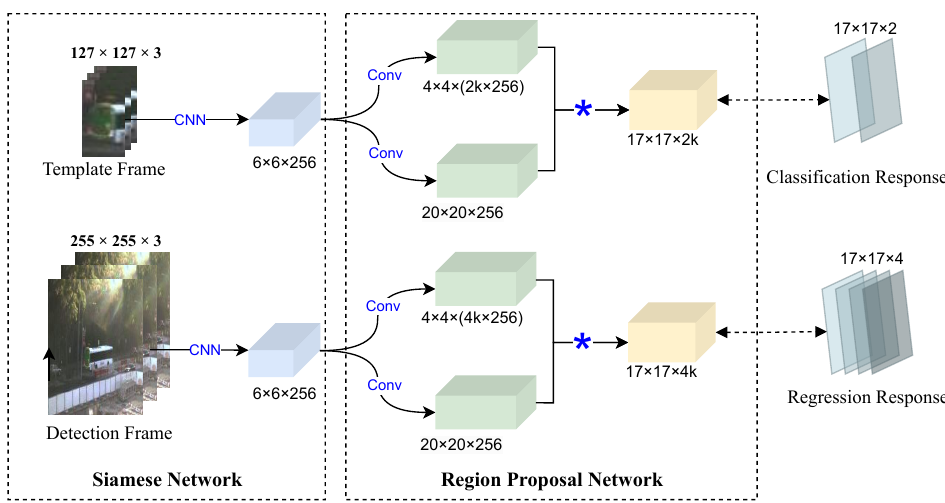
Figure 2. The framework of